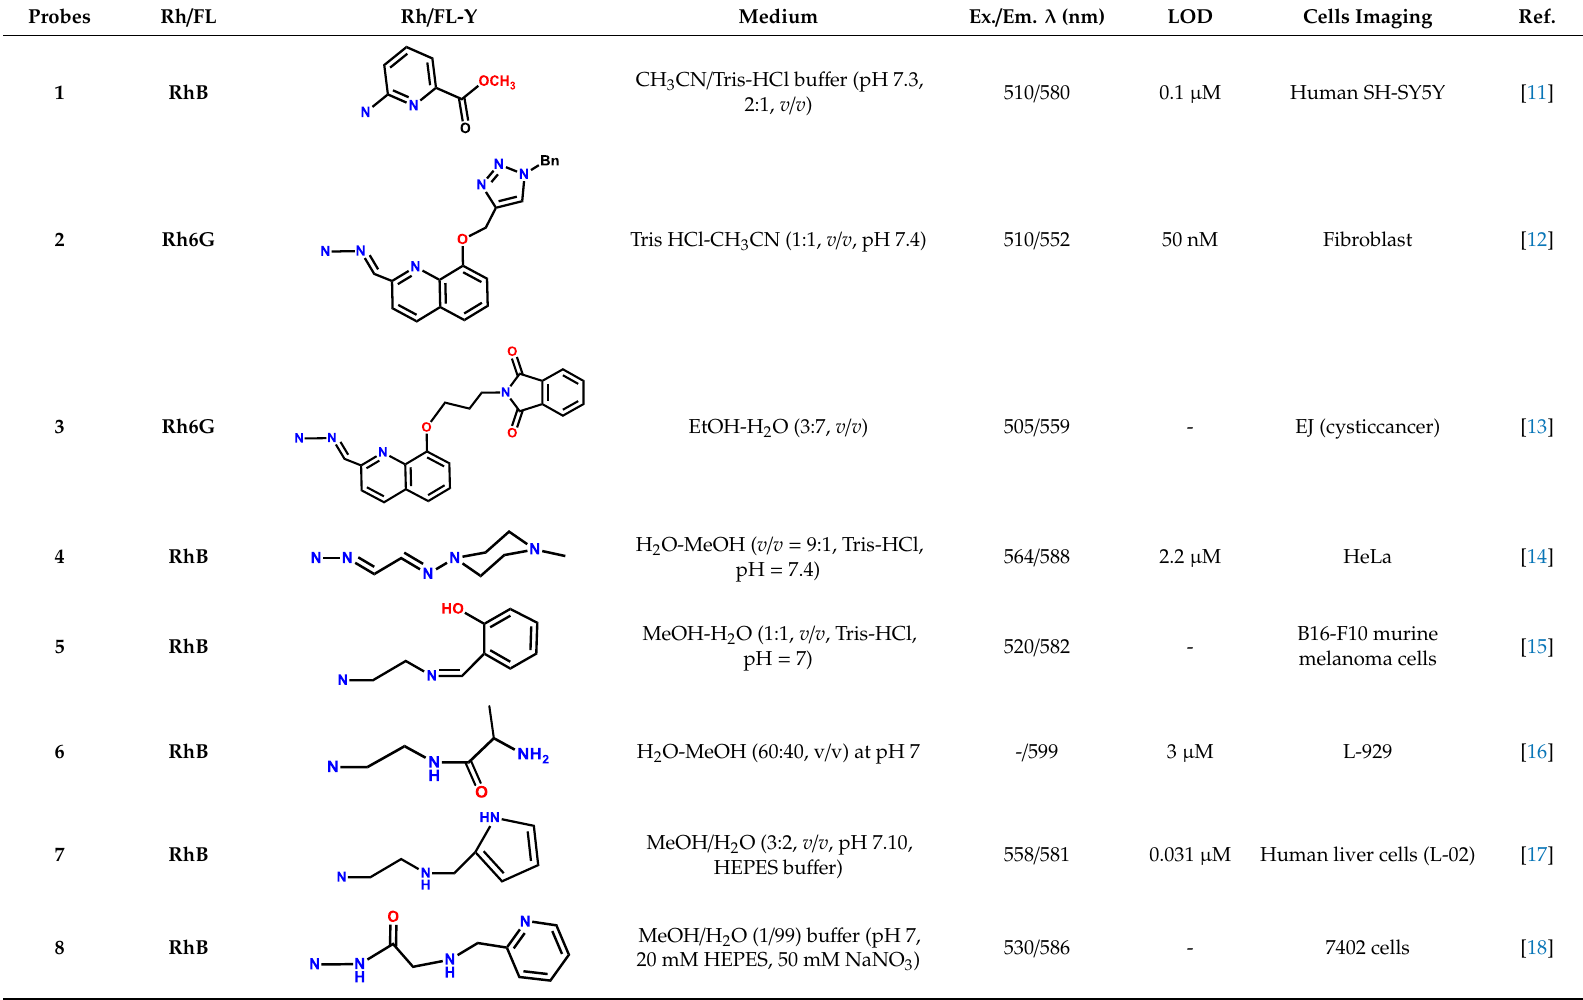
Table 1. Fe 3+ -selective rhodamine/fluorescein-based fluorescent turn-on probes.